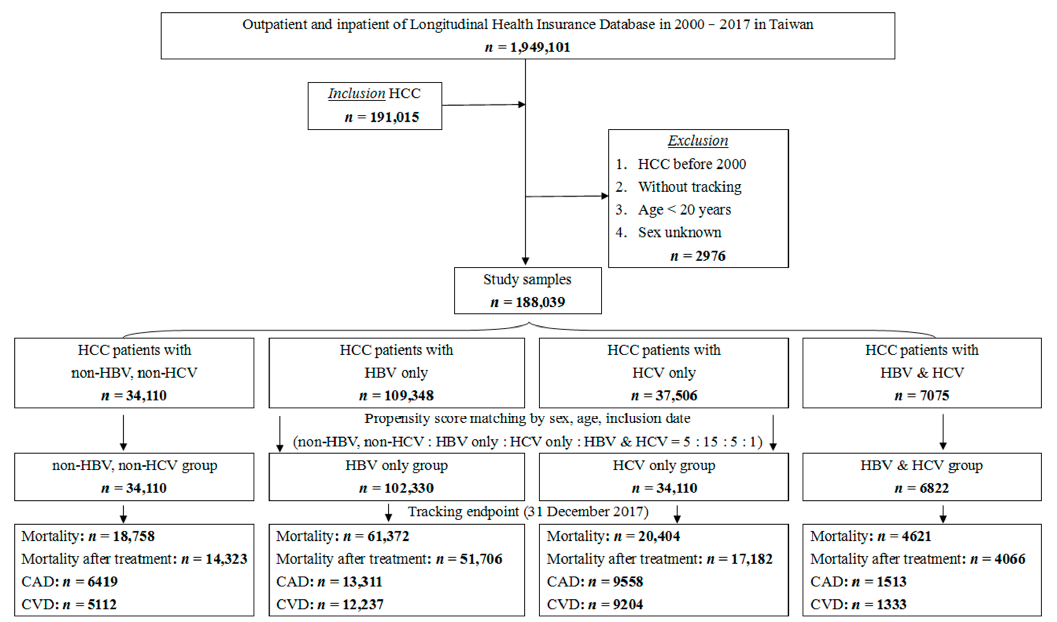
Figure 1. Flowchart of the study. The abbreviations: hepatocellular carcinoma (HCC); hepatitis B (HBV); hepatitis C (HCV); coronary artery disease (CAD); cerebrovascular disease (CVD).